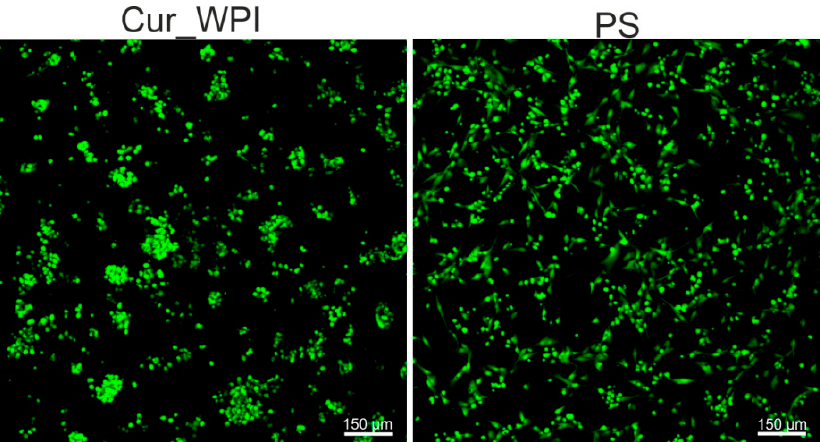
Figure 5. Confocal microscope images showing viability of chondrocytes cultured on Cur_WPI biomaterial and polystyrene (PS) after 48-h incubation. Live cells emitted green fluorescence, while dead cells gave red fluorescence. Magnification 100×, scale bar was 150 μ m.